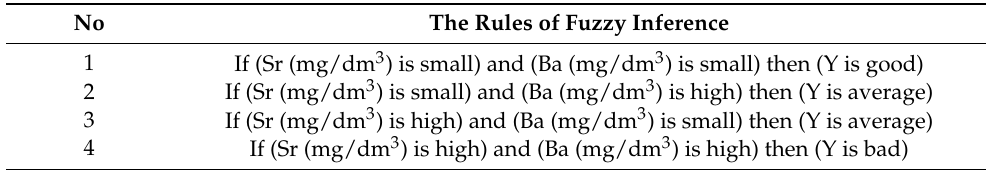
Table 5. Application of the fuzzy inference rule.